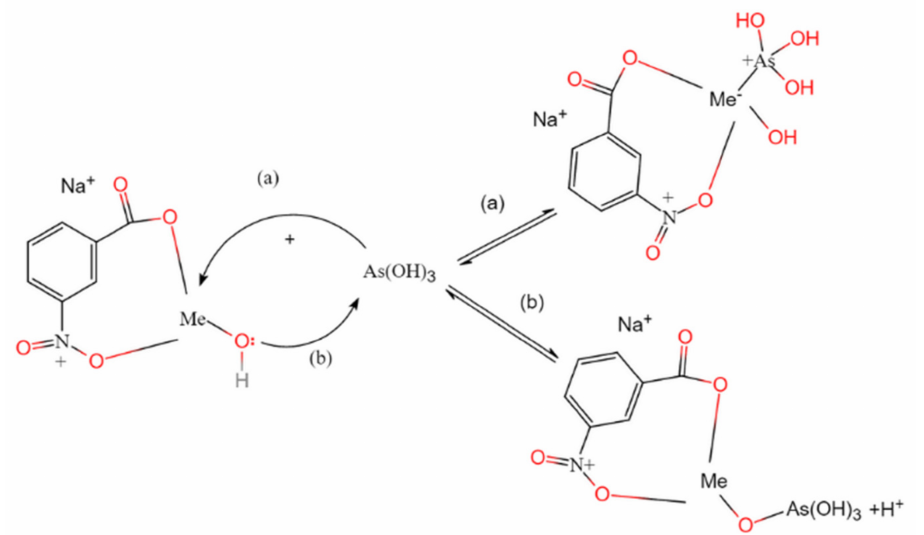
Figure 6. Possible adsorption mechanism of m-NBO on an arsenopyrite surface with two binding mechanisms involving m-NBO: a metal cation and arsenic (Me can be Fe 3+ ). a—is expected to be rather weak due to steric hindrance and repulsion of the OH − ligands and due to a small